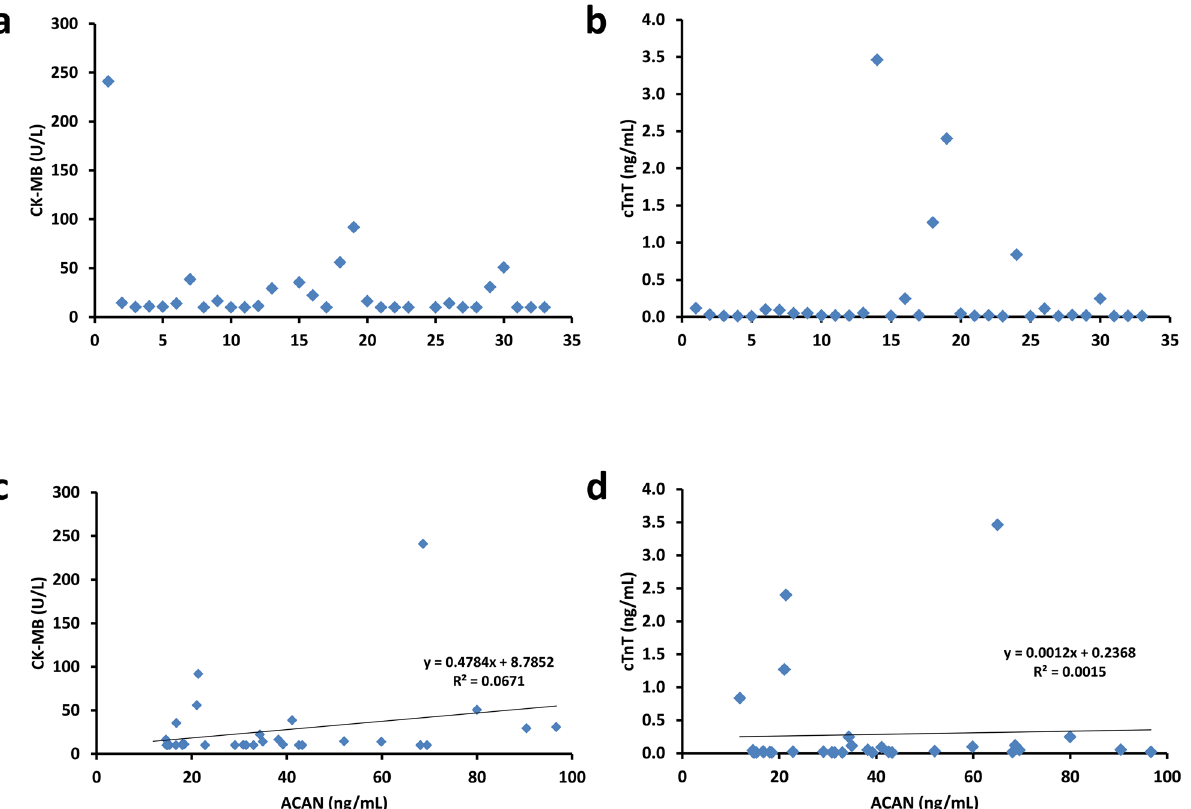
Figure 6. ACAN levels do not correlate with CK-MB or cTnT concentrations. (a) CK-MB levels of individual ATAAD patients. (b) Correlation between ACAN and CK-MB levels. (c) cTnT levels of individual ATAAD patients. (d) Correlation between ACAN and cTnT levels. ACAN aggrecan, CK-MB: creatine kinase-muscle brain isoform, cTnT cardiac troponin T, STEMI